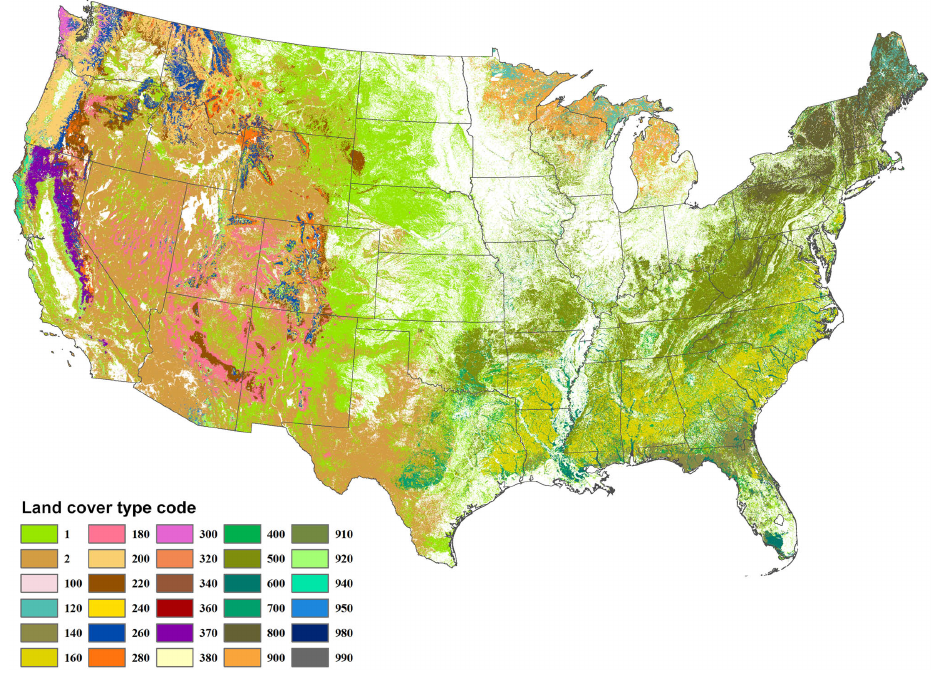
Figure 2. MFLEI land cover type map. White regions indicate the non-fuel cover type. Cover type codes are described in Table